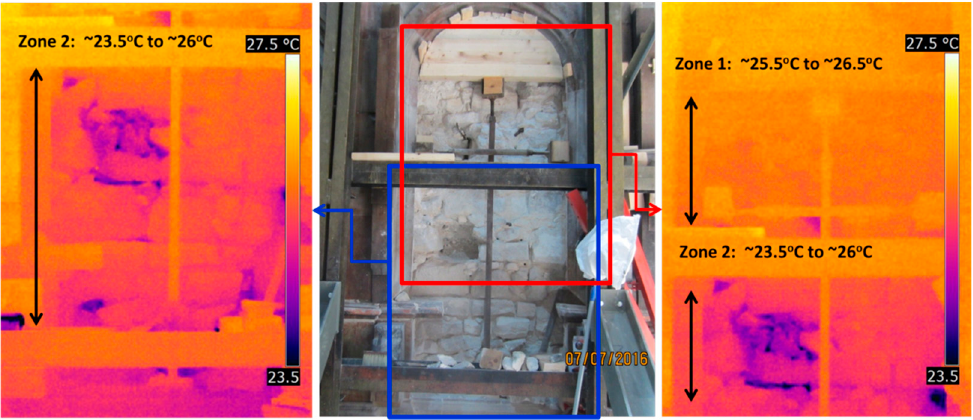
Figure 37. N2 panel masonry after filling mortar removal and respective IRT measurements.